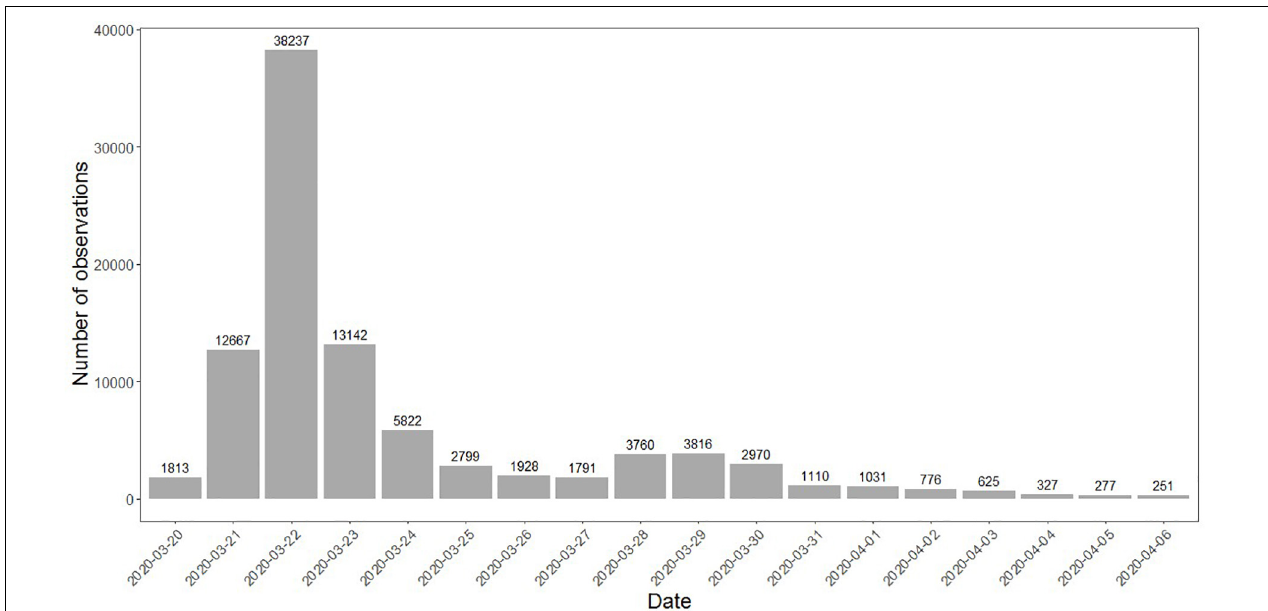
FIGURE 1 | Overview of observations per